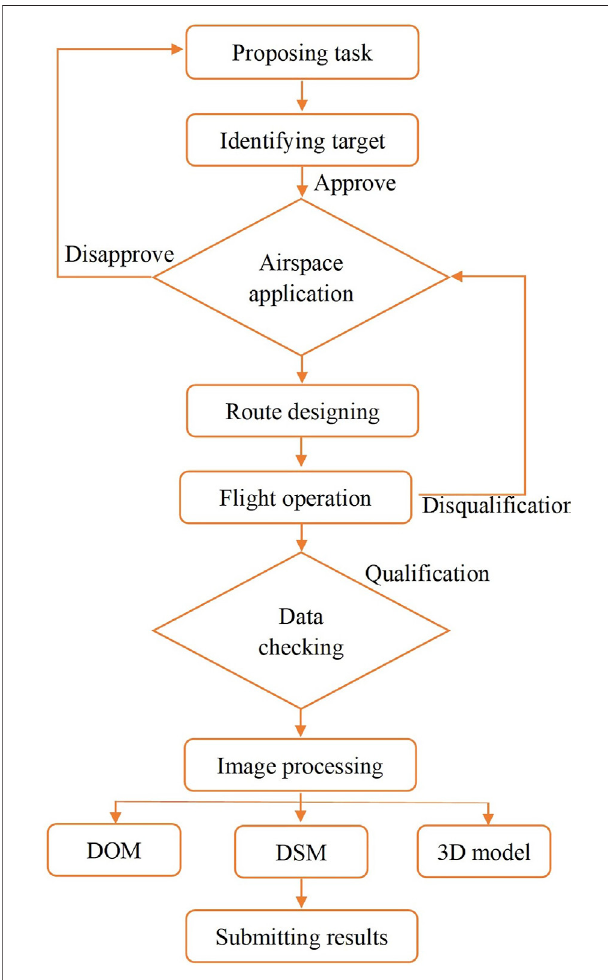
FIGURE 3 | UAV operation process.